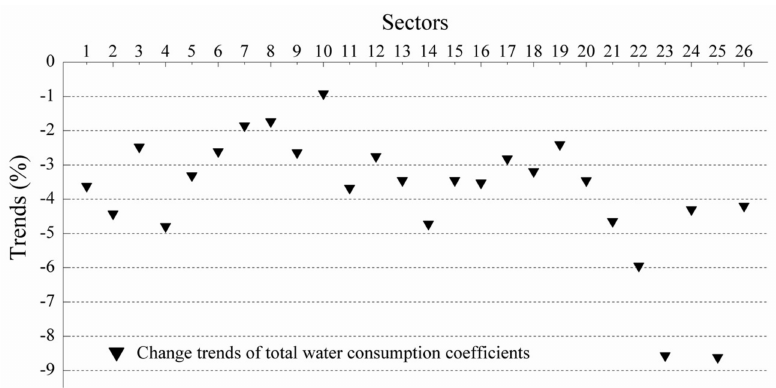
Figure 4. Change trends of total water consumption coefficients from 2002 to